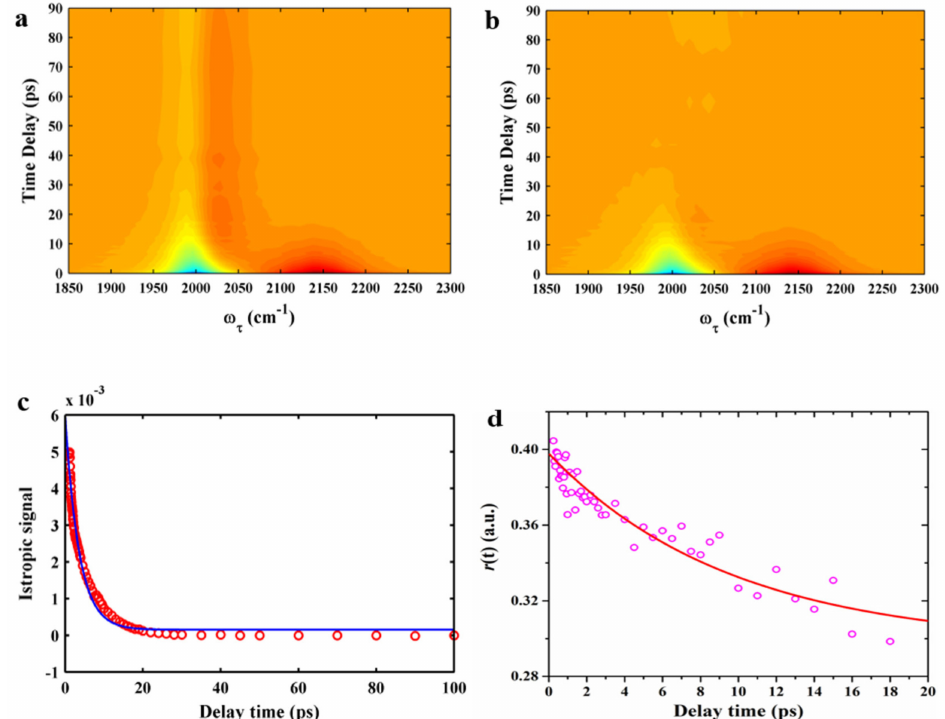
Figure 7. Time- and frequency-resolved isotropic IR pump–probe signals for 5ICI in DMSO before ( a ) and after ( b ) subtraction of the heat contribution. ( c ) Population decay of 5ICI in DMSO. The signal can be fitted to a single exponential function (blue line). ( d ) Anisotropy decays of 5ICI in DMSO. The signal can be fitted to a single exponential function (red